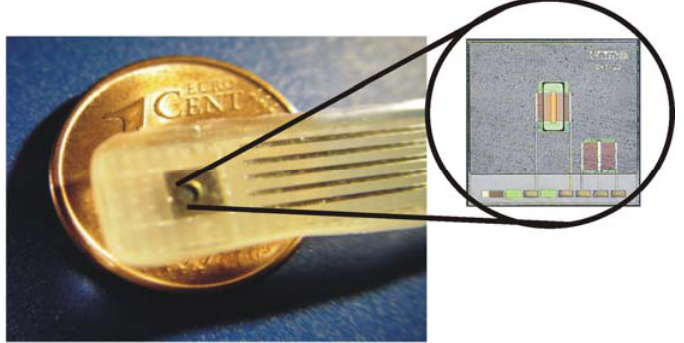
pre-encapsulation